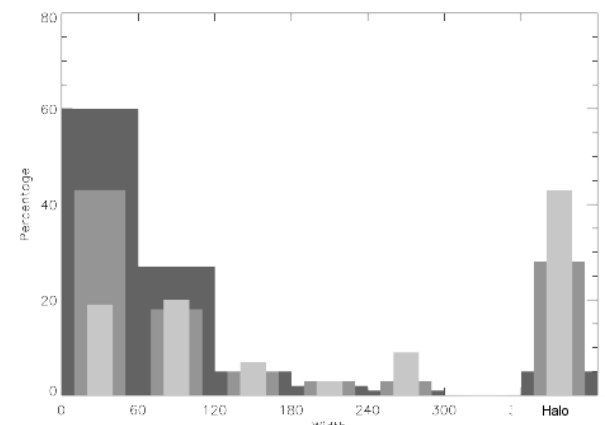
Fig. 8. In light grey: width (in ◦ ) distribution for the CMEs identi- fied in column 7 of Table 1. In dark grey: same histogram for the CMEs identified in column 6 of Table 1. In black: same histogram for all the CMEs identified in LASCO during the same